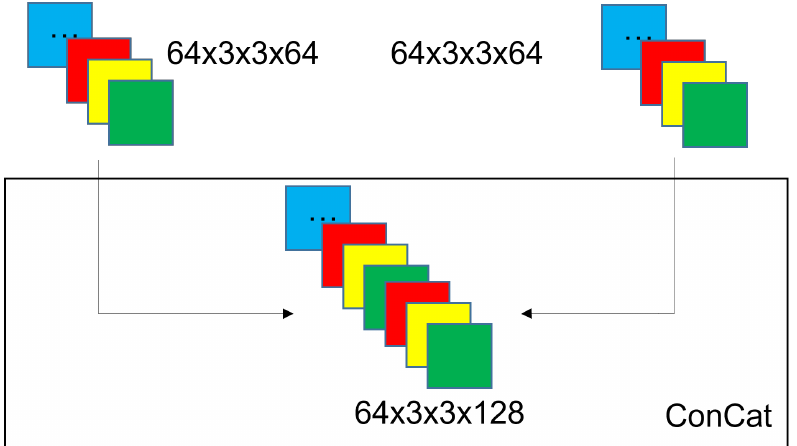
Figure 2. Sketch figure of concatenation